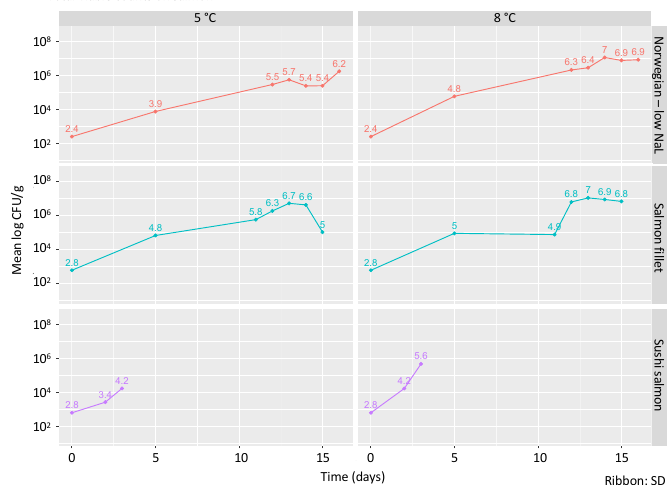
Figure 2. Total count of viable bacteria at 37 °C. The numbers above the time points reflect the mean log CFU / g from three replicates. The shaded area around the line represents the standard deviation.